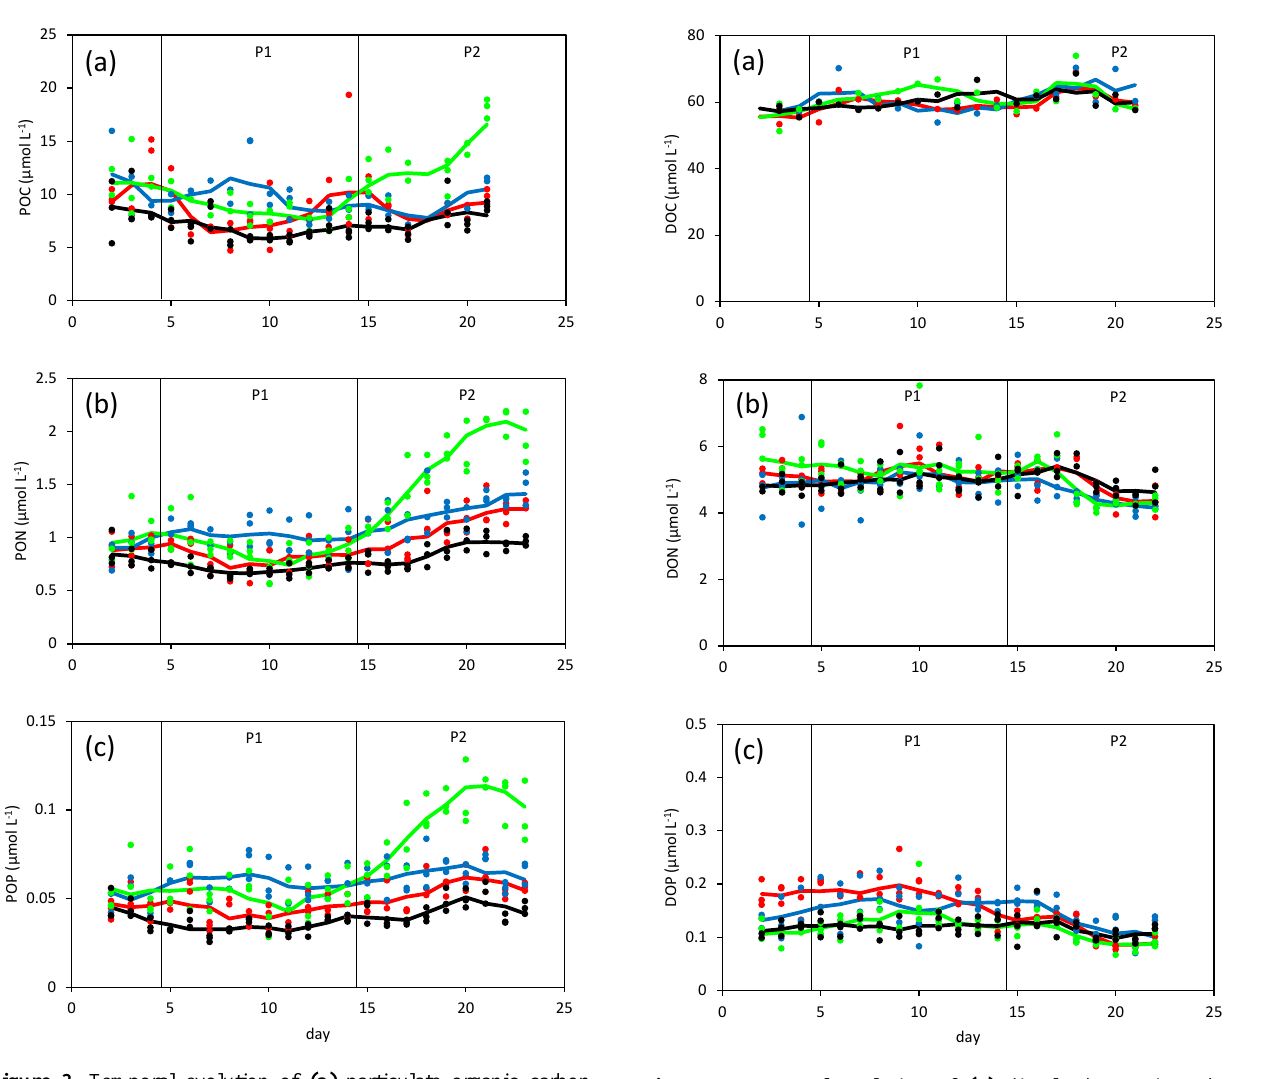
Figure 4. Temporal evolution of (a) dissolved organic carbon (DOC), (b) dissolved organic nitrogen (DON), (c) dissolved organic phosphorus (DOP) concentrations (µmolL − 1 ) in the mesocosms and surrounding waters. The color code is identical to that in Fig. 1. The three dots of each color represent the measured values at the three sampled depths. The solid lines are the 3-day running mean value. P1 and P2 denote the two phases of the experiment when the diazotrophic community was dominated by diatom–diazotroph associations and unicellular N 2 -fixing cyanobacteria (group C), re-